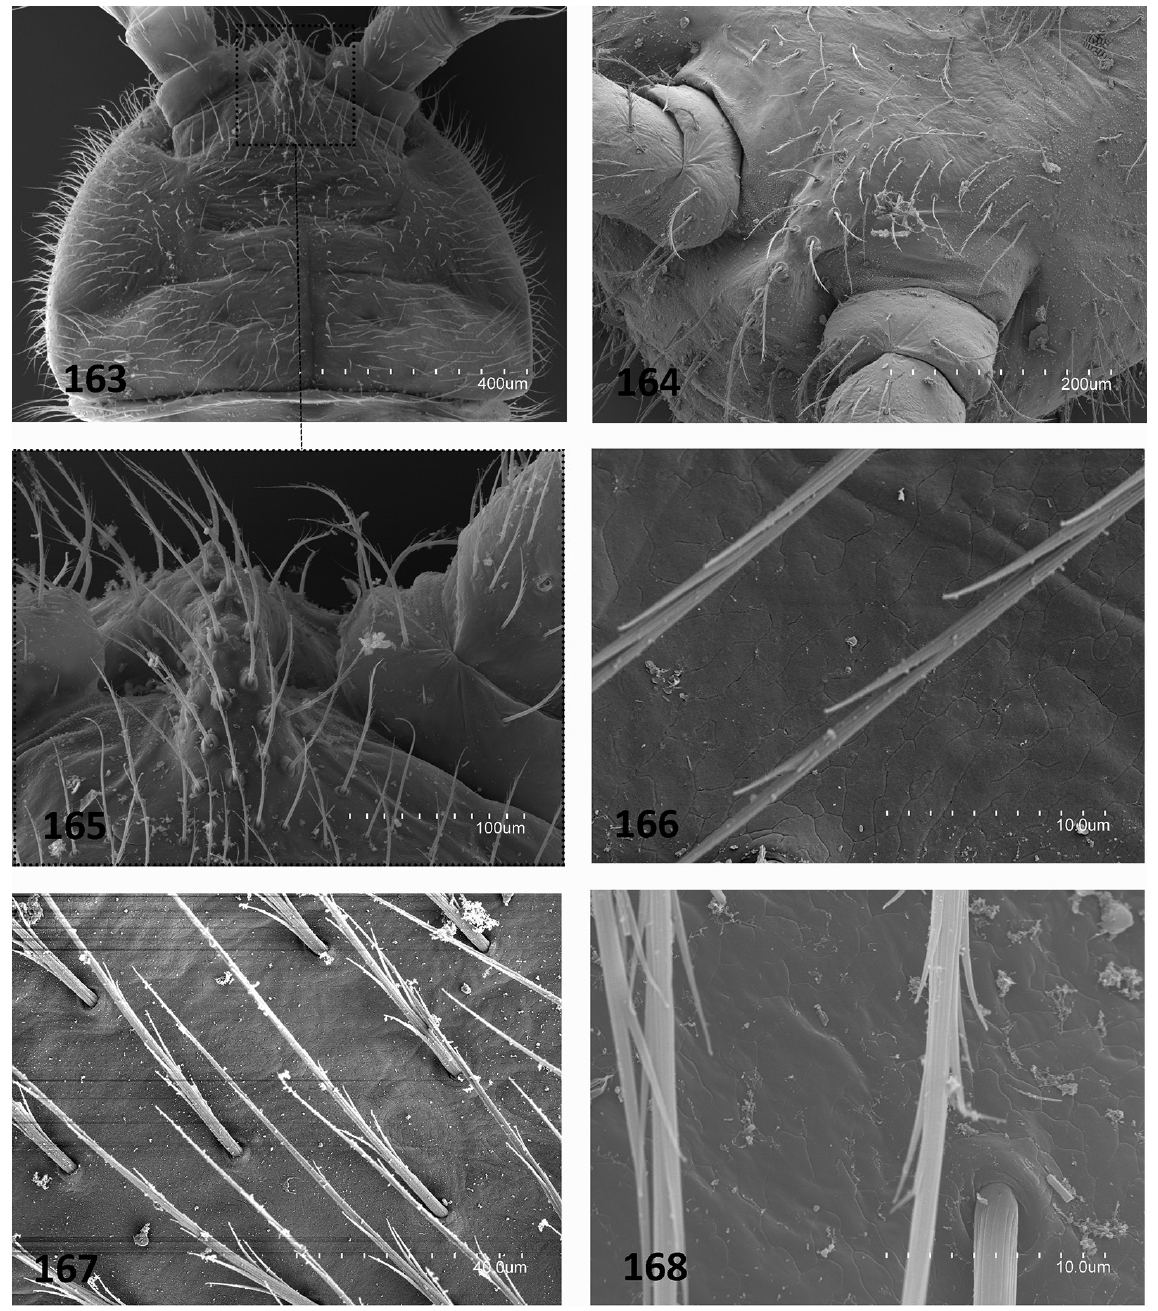
Figs 163–168. Plusiocampa ( Stygiocampa ) nivea (Joseph, 1882), from Velika ledena jama v Paradani, Predmeja, Slovenia (163–166, 168) and Volčja jama, Postojna, Slovenia (167) (Coll. AS) . 163 . Head, dorsal view. 164 . Head, lateral frontal view. 165 . Frontal process. 166 . Surface of mesonotum, detail. 167 . Clothing setae of metonotum. 168 . Surface of metanotum,